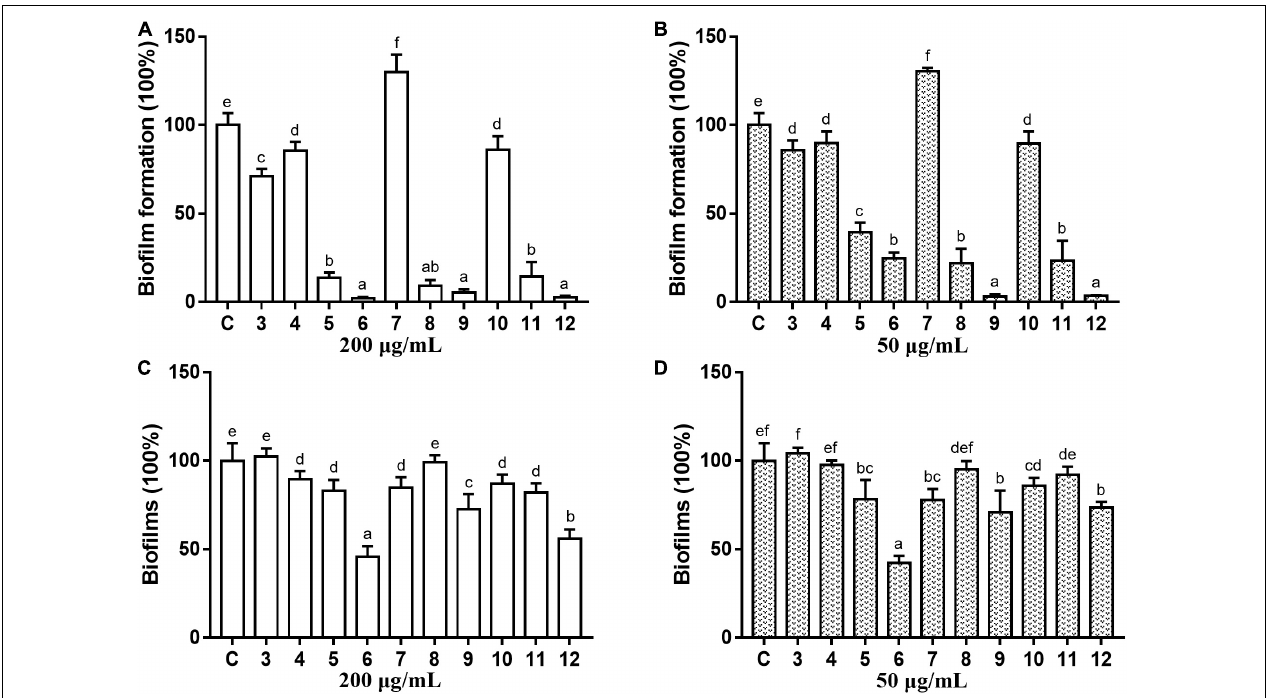
FIGURE 3 | Antibiofilm activity of commercial anthraquinones 3–12 against MRSA. The MRSA biofilm inhibitory activity (A,B) and the biofilm eradication activity (C,D) of each compound at two different concentrations ( A,C 200 µ g/ml; B,D 50 µ g/ml). The same volume of DMSO was used as negative control. C, control. Results are presented as percentages of the control group. The data represent mean ± SD ( n = 9). Means in a group with different letters are significant differences based on Ryan-Einot-Gabriel-Welsch multiple F -test, p < 0.001.